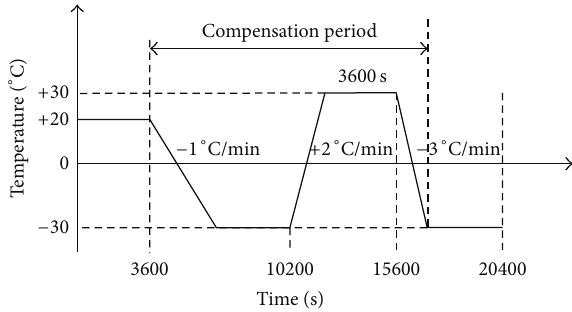
Figure 6: The procedures of the temperature